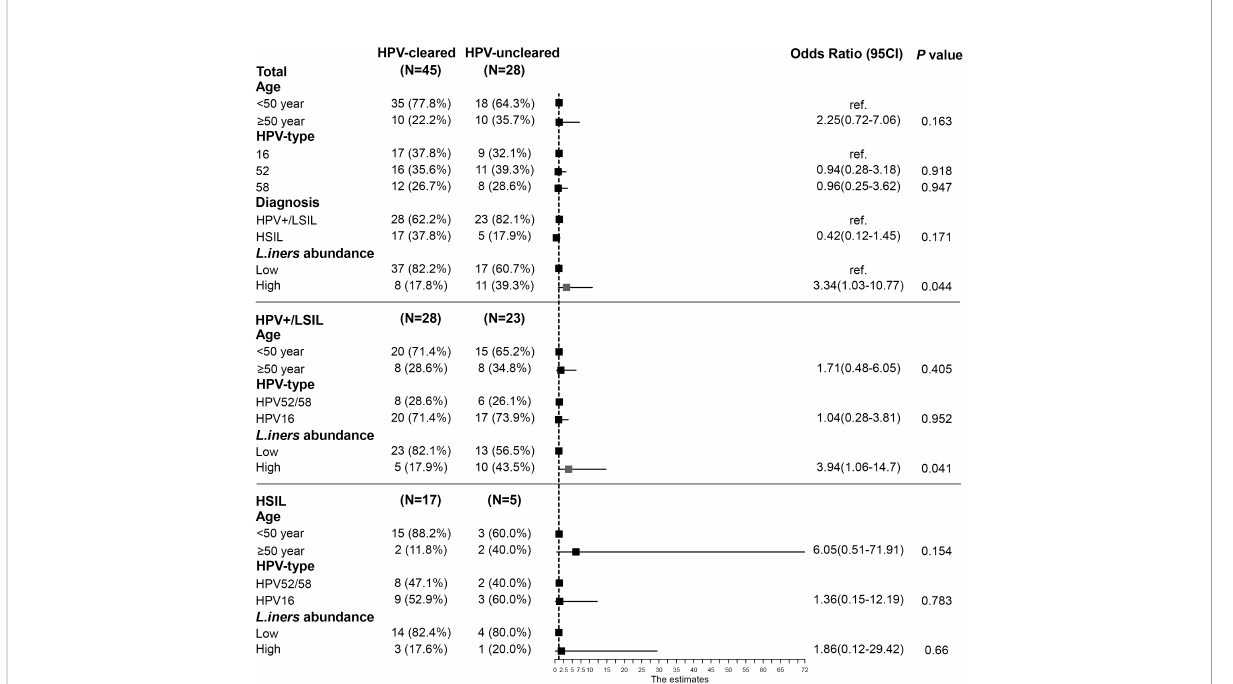
FIGURE 5 Association between L. iners abundance and HPV clearance in a 12-month follow-up. Forest plots were shown using data from multivariable logistic regression in total and according to disease status. HSIL patients received surgical resection, and LSIL/HPV+ patients underwent a surgical treatment. The abundance of L. iners was categorized by 75th quartile scores. HPV, human papillomavirus; LSIL, low-grade squamous intraepithelial lesion; HSIL, high-grade squamous intraepithelial